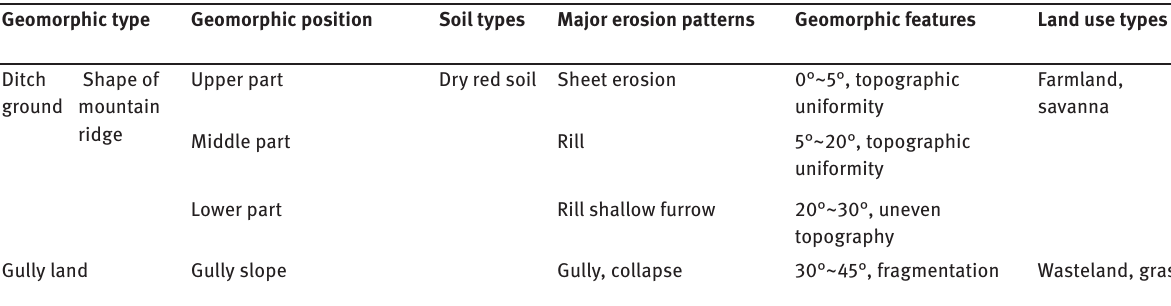
Table 1: The cross sectional survey area in the small watershed of the study